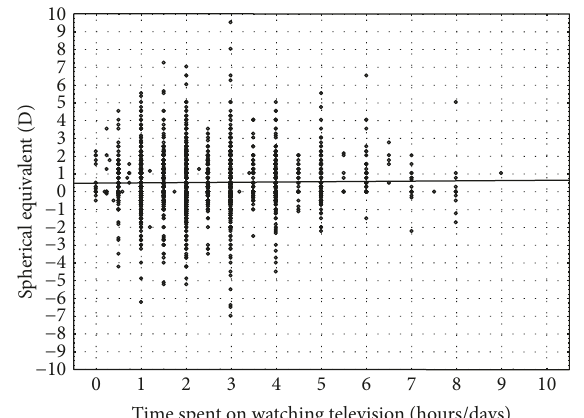
Figure 3: Mean spherical equivalent in relation to watching television.